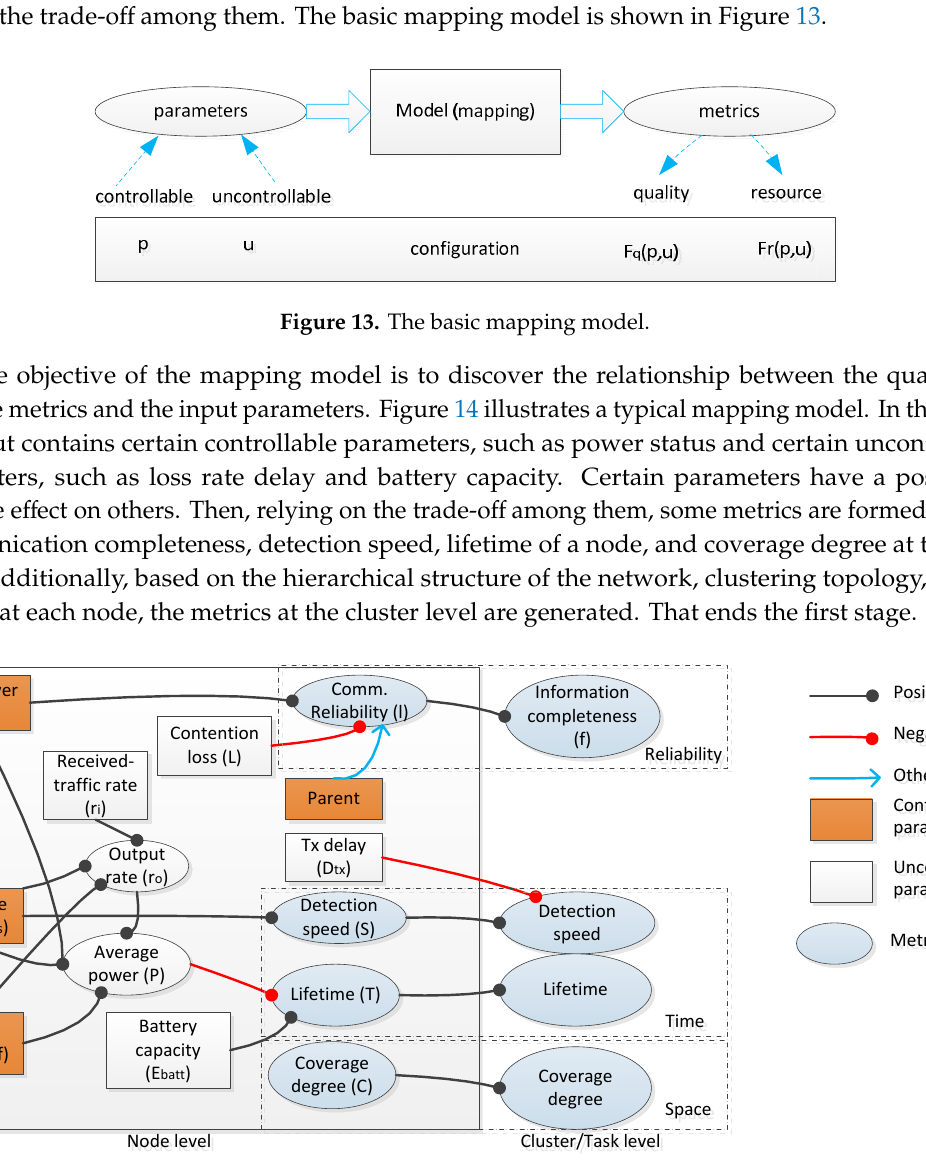
Figure 14. The hierarchical trade-off model.